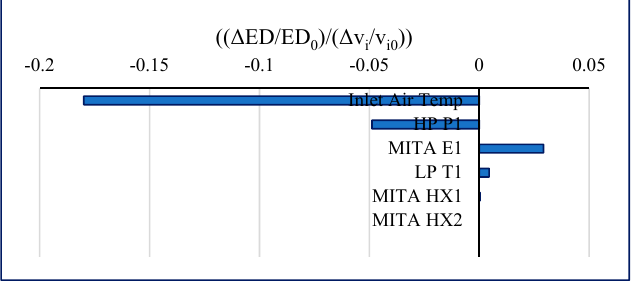
Figure 11. Jacobian matrix elements ranked according to their absolute value.